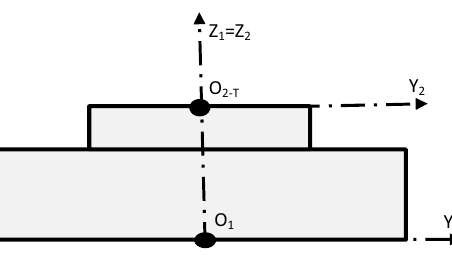
Fig. 3. Presentation of target